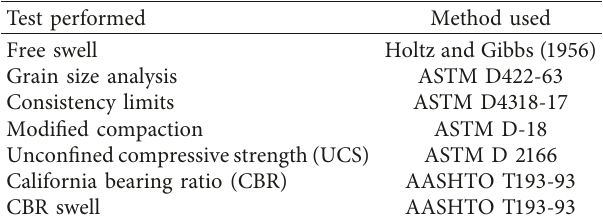
Table 2: Tests and methods. Test performed Method